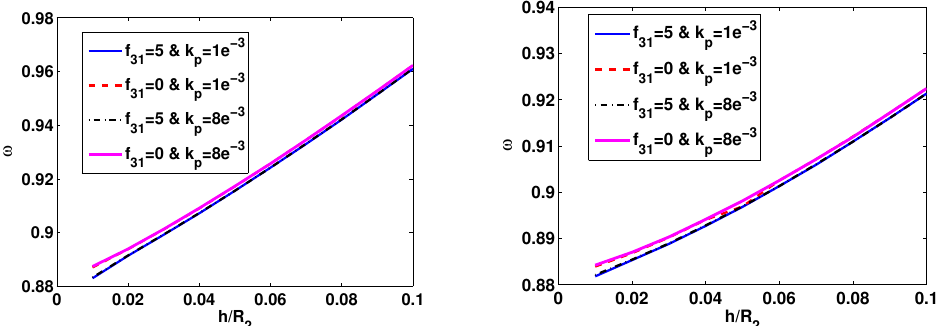
Figure 6. The effect of flexoelectric term and Pasternak coefficient on the frequency of FGM conical nanoshells ( α = 30, p = 1, k w = 10 × e 12 , h p / h = 0.1, ( left ) clamped-clamped boundary conditions, ( right ) clamped-simply boundary